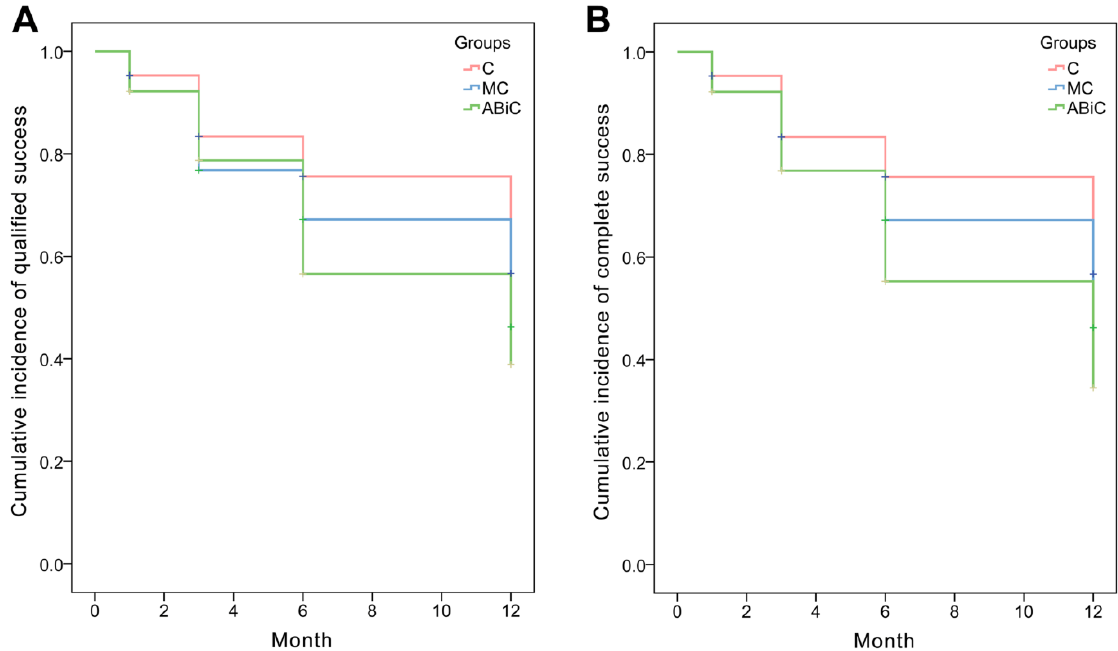
Figure 2. Kaplan–Meier survival analysis: ( A ) qualified success (IOP ≤ 15 mmHg with or without medications) and ( B ) complete success (IOP ≤ 15 mmHg without medications).